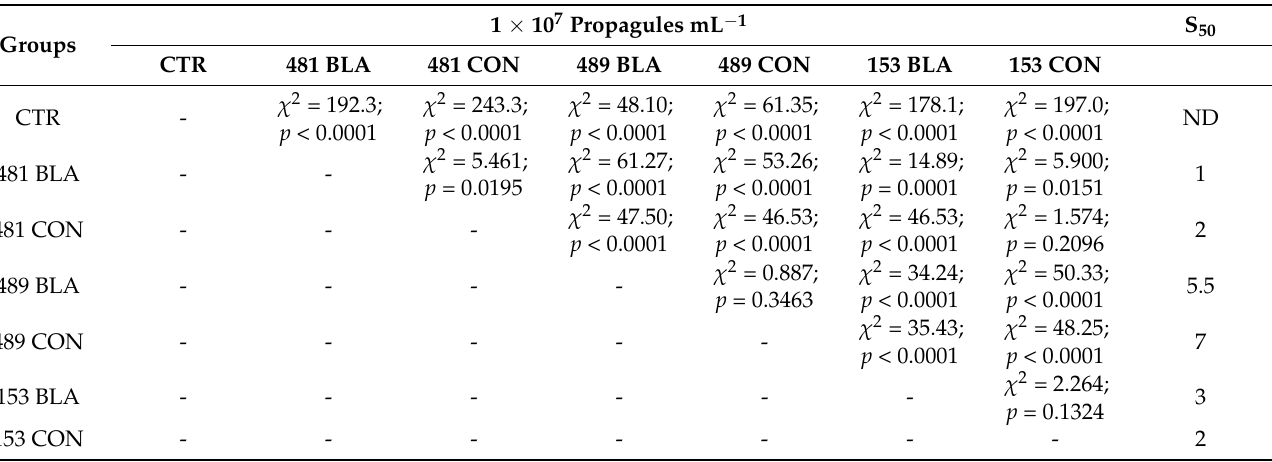
Figure 2. Survival curves of Aedes aegypti larvae exposed to conidia (CON) or blastospores (BLA) of Metarhizium anisopliae s.l strains or exposed to Tween 80 at 0.03% (CTR). Significance levels were calculated, and their strength was displayed with the symbol (**** p < 0.0001) compared with the control group. Table 1. Log-rank pairwise comparisons of survival rates and median survival time (S 50 ) of Aedes aegypti 2nd instar larvae exposed to Metarhizium anisopliae strains or exposed to Tween 80 at